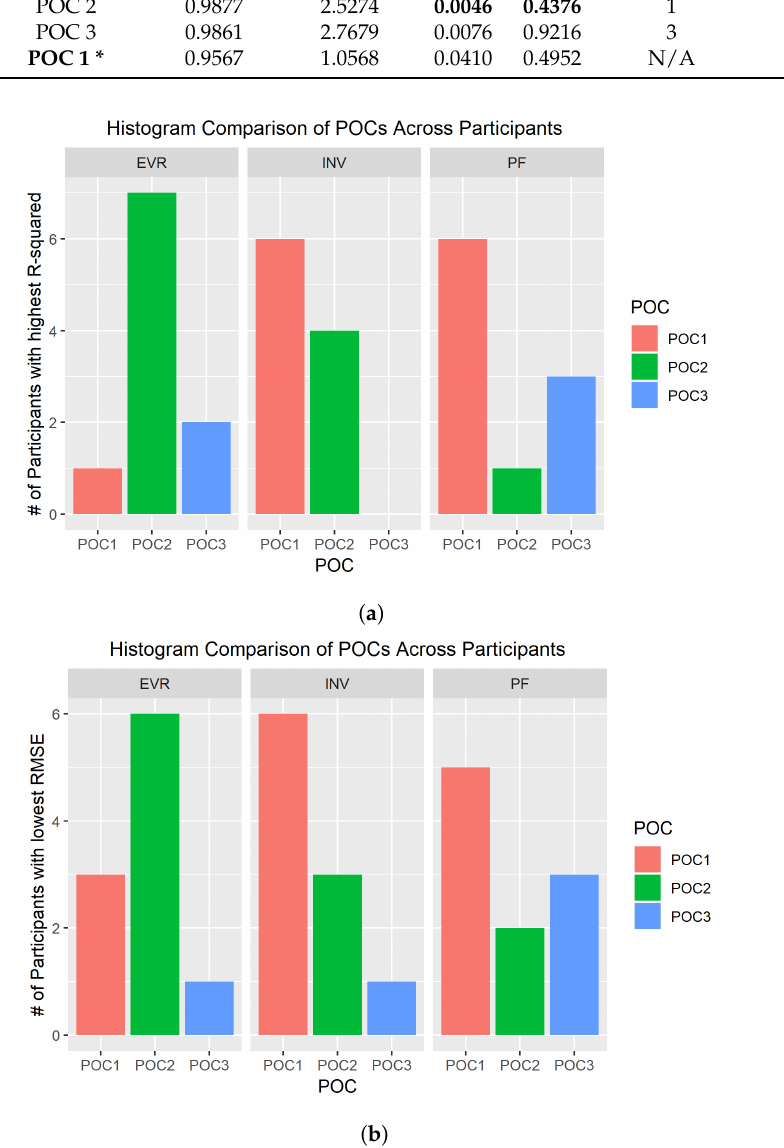
Figure 10. Number of participant counts: ( a ) number of participants where SRS POC resulted in the highest R 2 values; and ( b ) number of participants where SRS POC resulted in the lowest RMSE